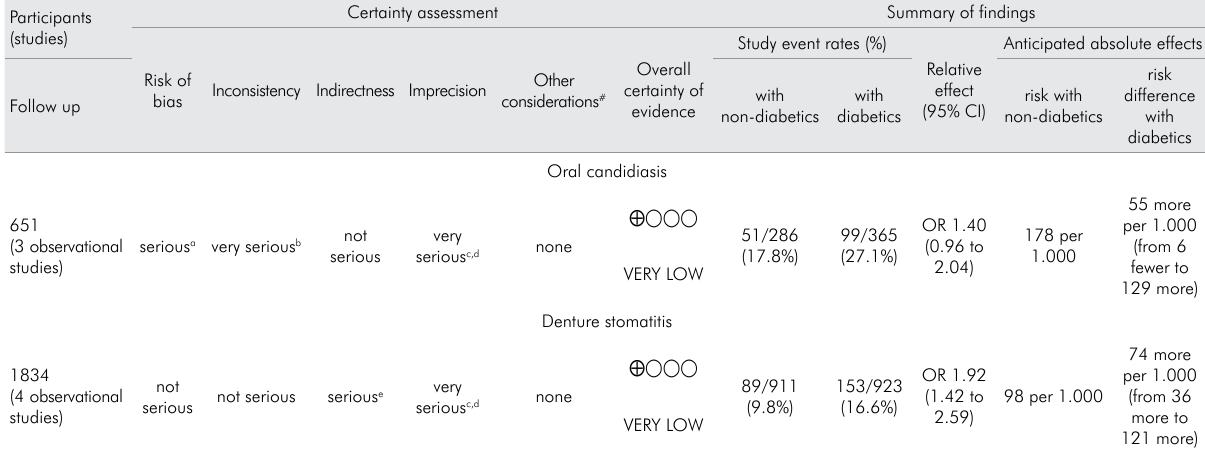
Table 5. Quality of evidence: Association of diabetes mellitus with oral candidiasis and denture stomatitis.